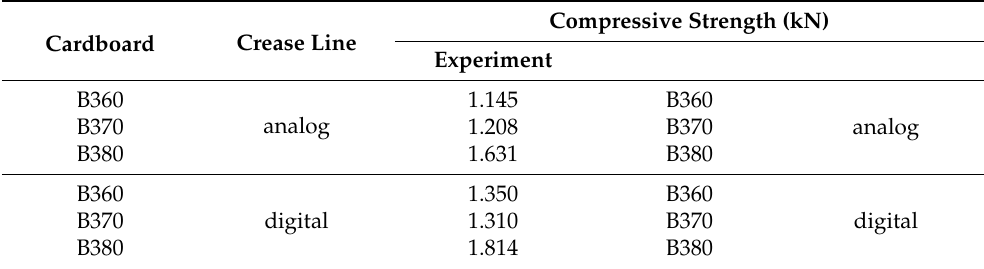
Table 8. Experimental results versus estimation using two different numerical models. Model A with the effect of crushing next to the creasing line and Model B without this effect.